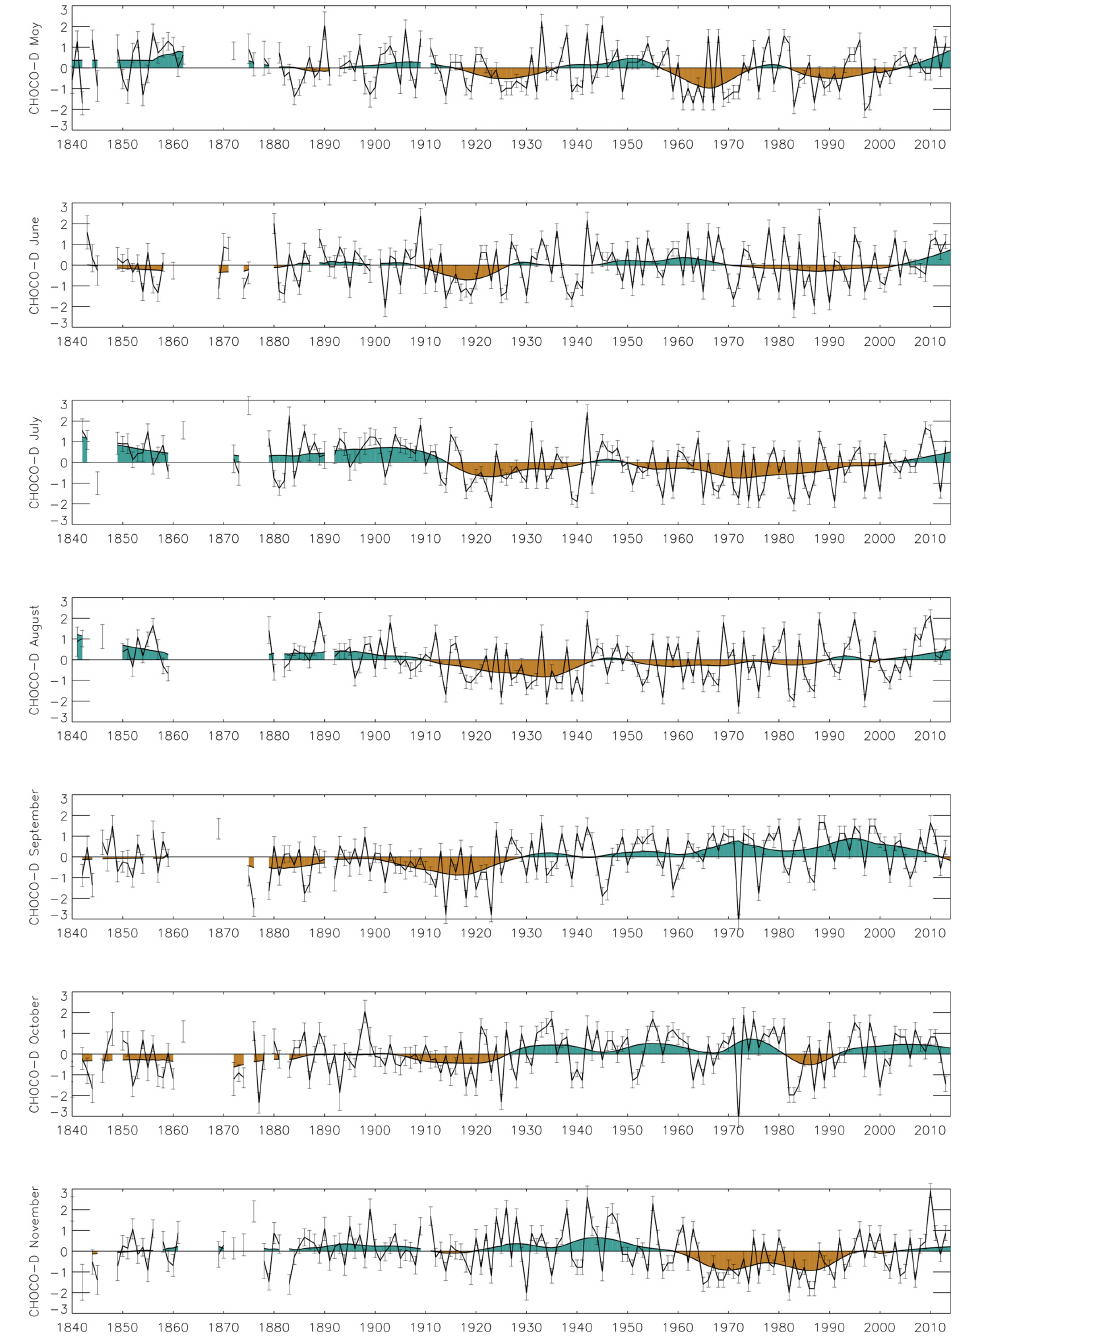
Figure 9. Standardized CHOCO-D for May to November between 1840 and 2014. Error bars indicate the expected standard deviation based on the number of observations available each year in ICOADS 3.0 (see text for details). Shaded smoothed curve is computed as a robust locally weighted regression with a 31-year window (Cleveland,